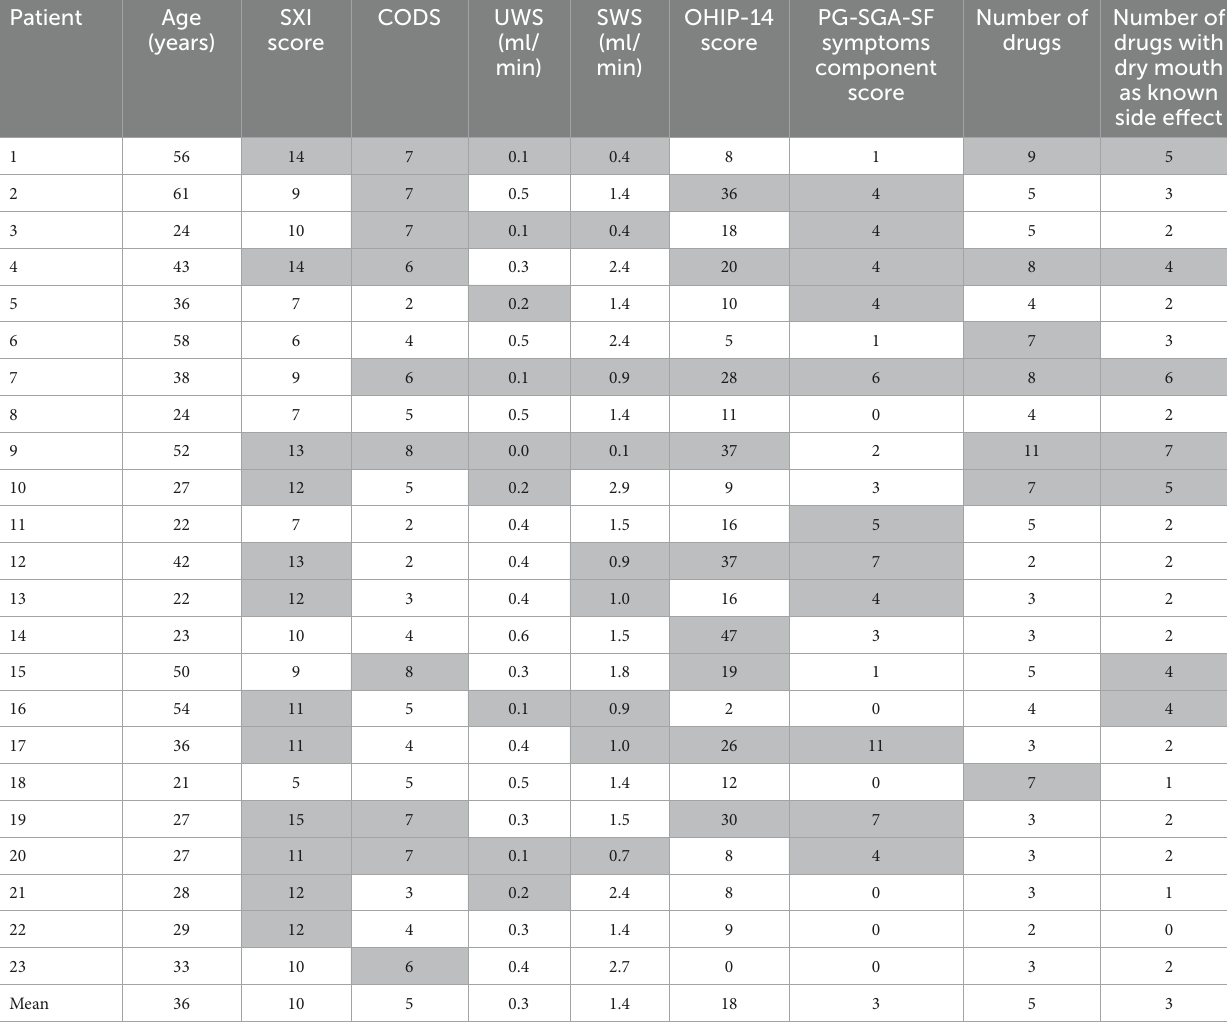
TABLE 12 Results from Summated Xerostomia Inventory (SXI), Clinical Oral Dryness Score (CODS), unstimulated whole saliva (UWS), stimulated whole saliva (SWS), Oral Health Impact Profile-14 (OHIP-14), the symptoms component of Patient-Generated Subjective Global Assessment Short Form (PG- SGA-SF), number of drugs and number of drugs with dry mouth as a known side effect for the specific